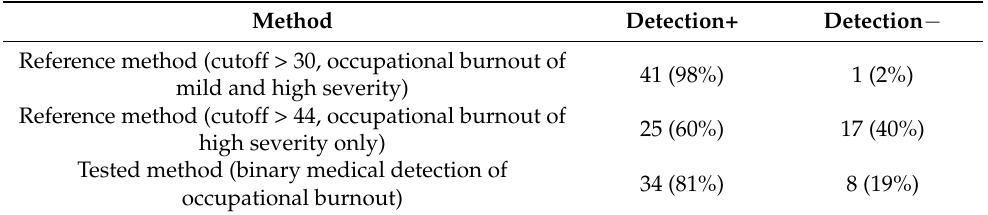
Table 1. Number of patients diagnosed with occupational burnout according to the reference and the tested methods.